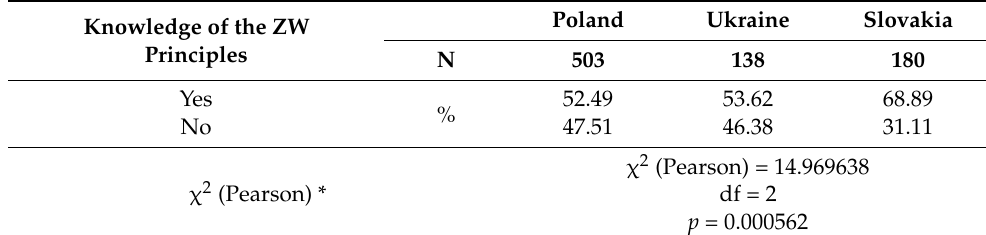
Table 5. Knowledge of the ZW principles among respondents from Poland, Ukraine and